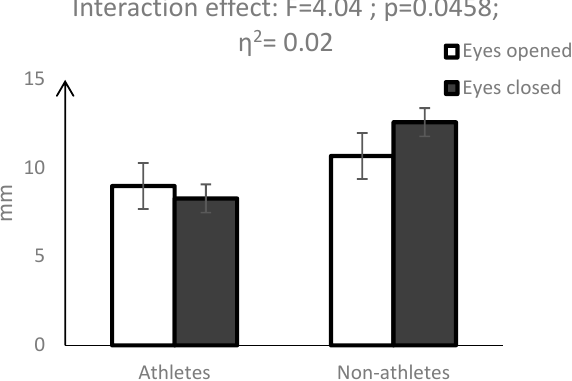
Figure 2. Mean values and 95% confidence interval for the width of the COP ellipse (WoE), along with the results of the interaction between group and vision factors.